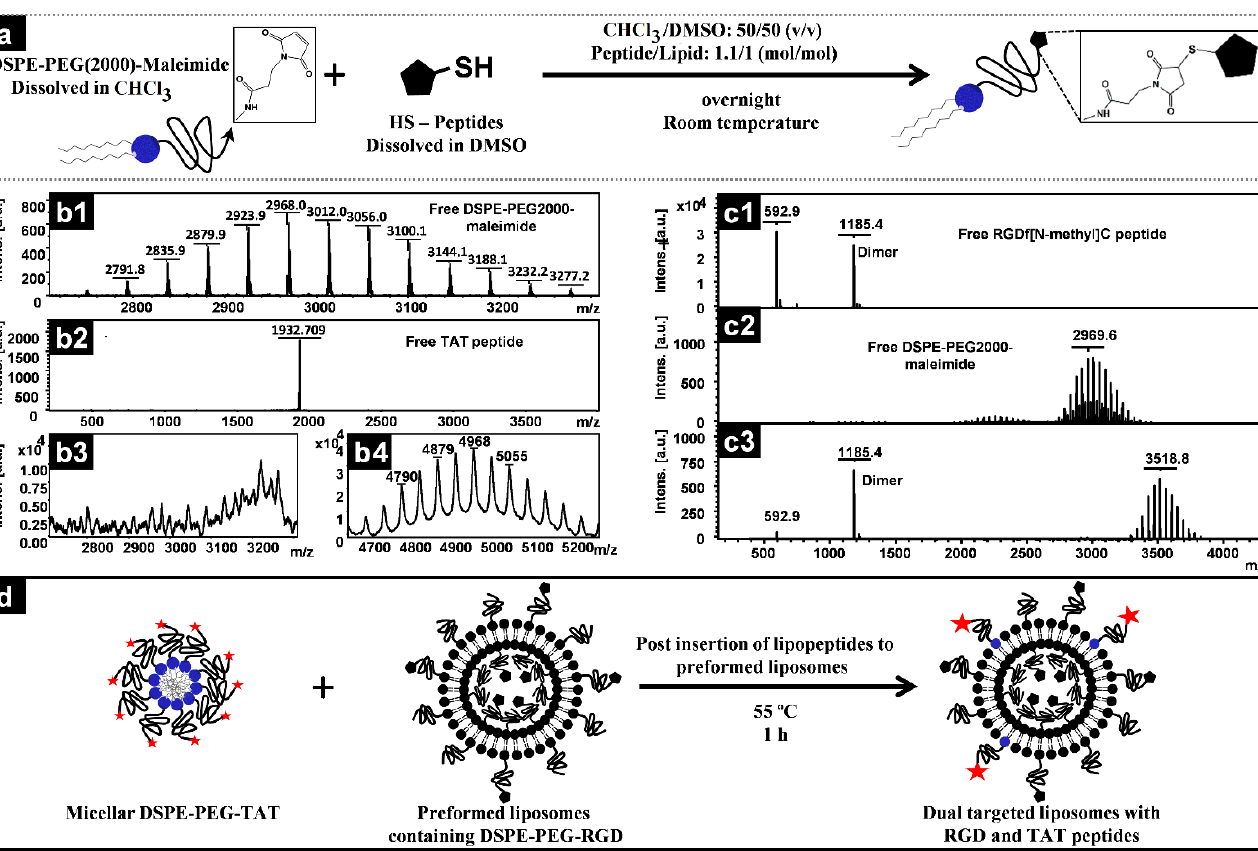
Figure 1. Schematic representation of the coupling reaction of HS-peptides to maleimide-functionalized phospholipids ( a ), the corresponding mass spectral (MALDI-TOF) data for free DSPE-PEG2000-maleimide ( b1 , c2 ), free TAT ( b2 ), free RGD ( c1 ), consumption of free lipids in reaction mixtures ( b3 , c3 ), and formation of lipopeptide conjugates ( b4 , c3 ). ( d ) illustrates the schematic of preparation of dual-targeted liposomes by postinsertion of TAT-lipopeptide into preformed